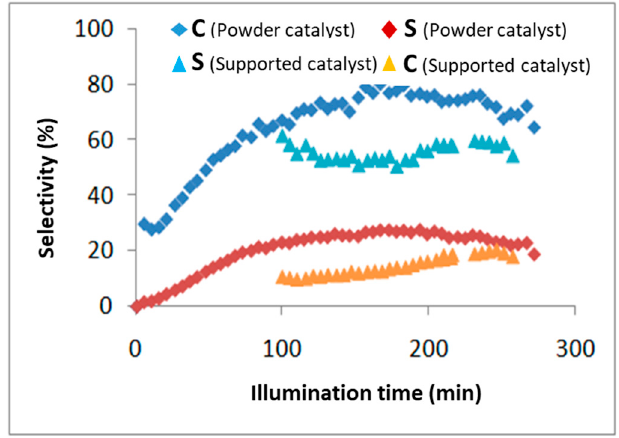
Figure 9. C and S balance for powdery and immobilized TiO 2